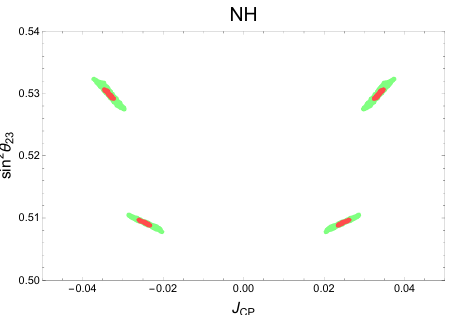
Figure 1 . Predicted CP violation versus atmospheric angle for NH. Green (Red) regions correspond to 3 (1) (cid:27) values for the solar and reactor angles in eqs. (5.18), (5.19). All predicted values for sin 2 (cid:18) 23 lie inside its 1 (cid:27) region, according to the global (cid:12)t [47]. Eliminating ! in the above relations using eq. (5.11), the mixing parameters 12